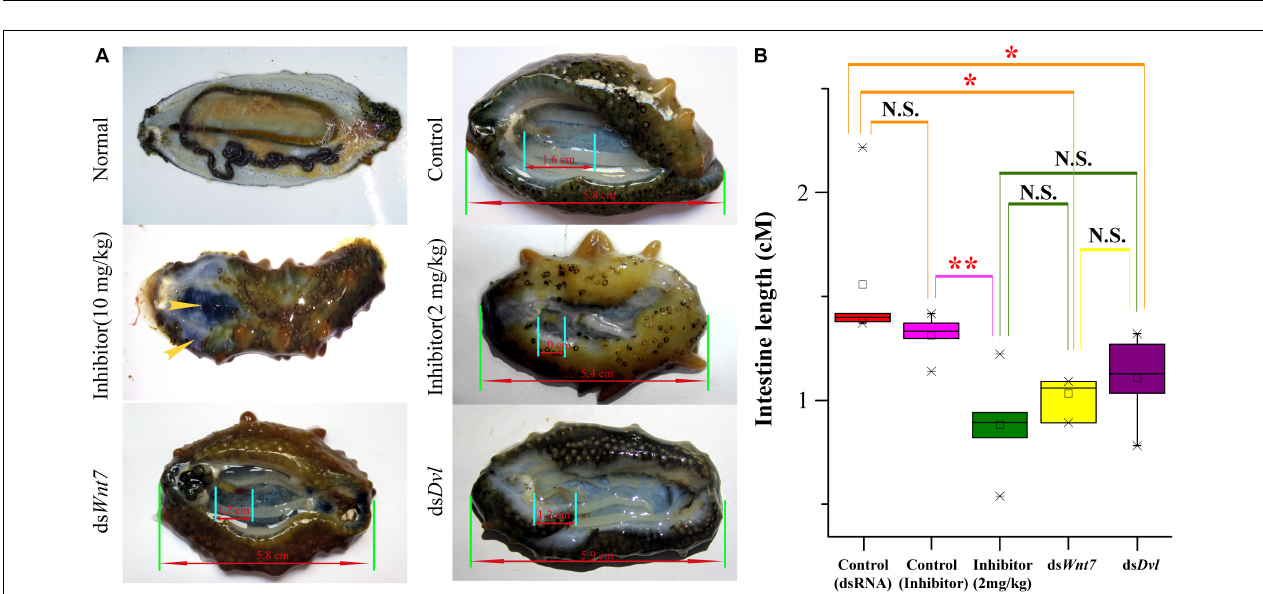
FIGURE 7 | The intestinal regeneration after injection of dsRNA and inhibitor. (A) Photos of the intestinal regeneration after injection of inhibitor (10 and 2 mg/kg), ds Wnt7 , ds Dvl , and ds EGFP (Control). As the performance of the negative controls of dsRNA and inhibitor were similar, only the control of dsRNA was displayed. (B) Distributions of the intestinal lengths of different treatment groups. Independent samples t -test was used to test the significant differences. ∗∗ p < 0.01, ∗ p < 0.05, and N.S., significant differences.